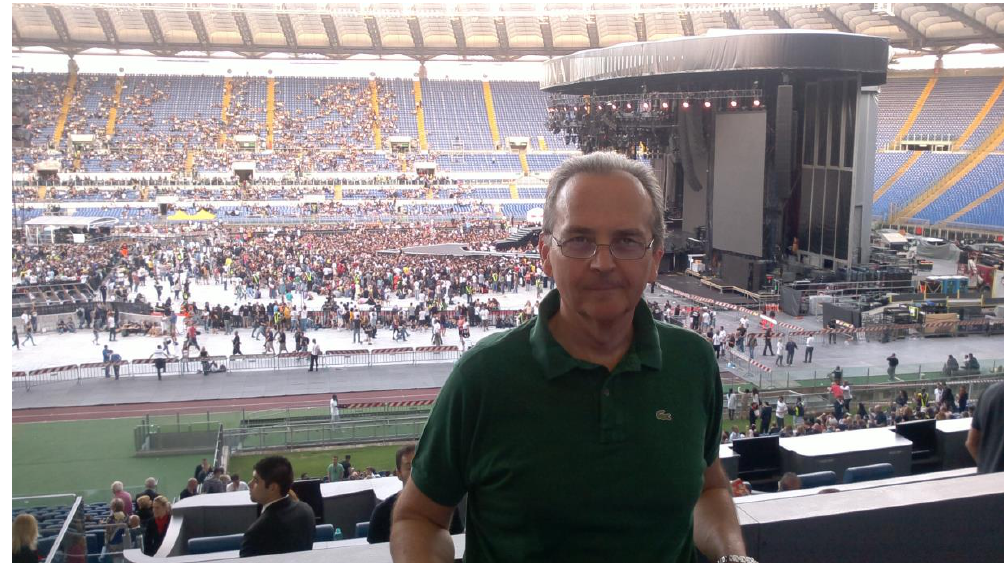
Figure 1. Prof. Paolo Cappa at the Stadio Olimpico of Rome for a concert.